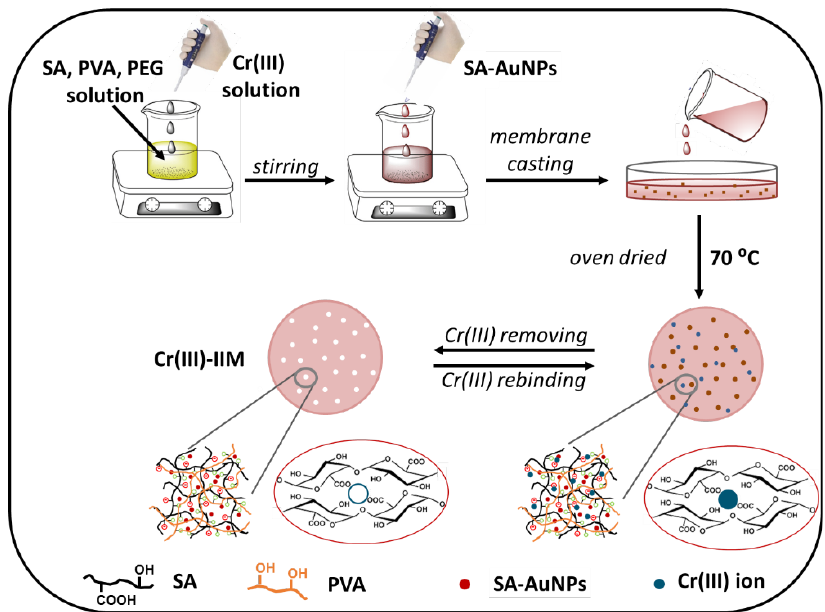
Figure 1. Schematic representation of the hydrogel Cr(III)-IIMs